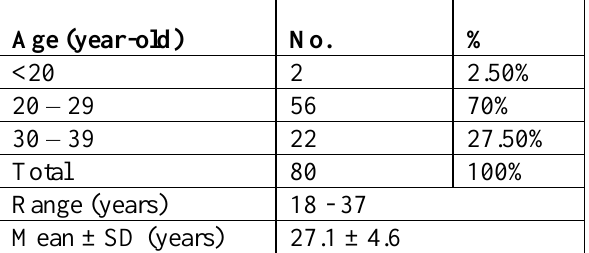
Table-1: Age distribution of the sample Age (year-old)